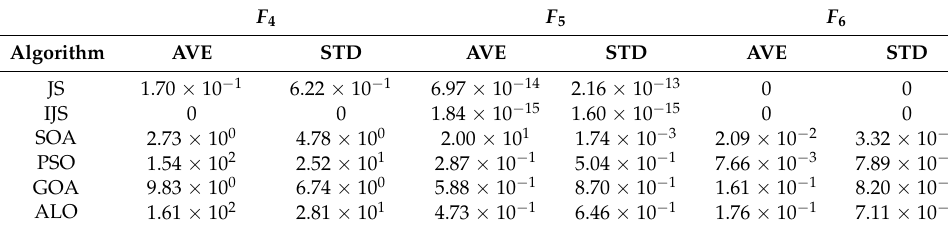
Table 4. The results of each algorithm under the multi-peak test